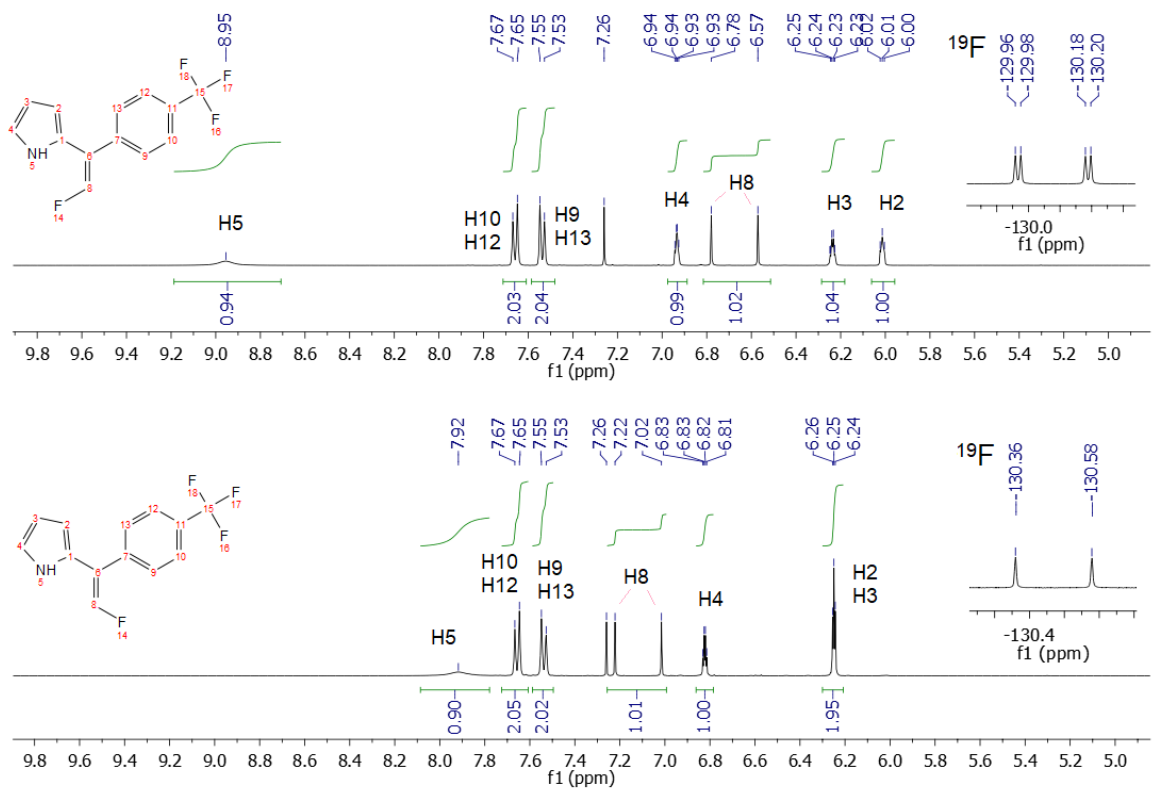
Figure 5. Comparison of the 1 H and 19 F NMR spectra for the Z - and E -isomers of 4i . As expected, the resulting ratio of the diastereomers 4 remained similar to that of the precursors 3 . However, the elimination of the 2,4-dichlorophenyl-substituted adduct 3b with dr = 48:52 led to the predominant formation of a Z -isomer 4 in high diastereomeric excess (90% de